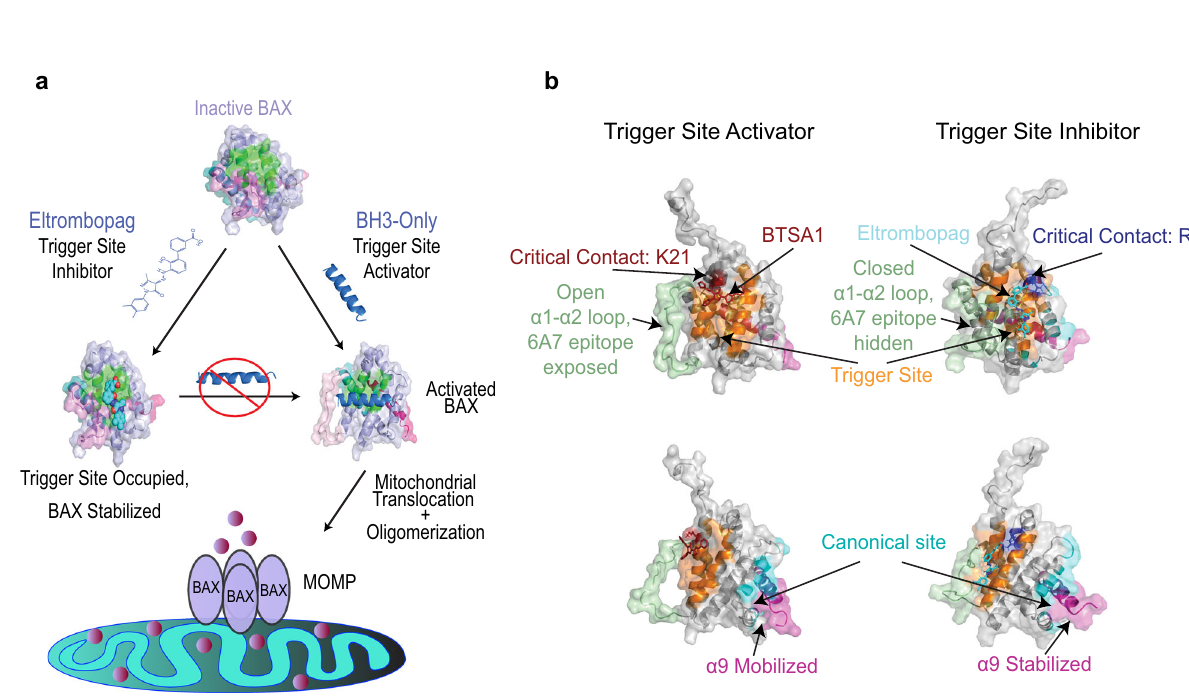
Fig. 7 Eltrombopag inhibits BAX activation by a unique twofold mechanism. a Eltrombopag ’ s binding to the BAX trigger site competes off BH3-only activator proteins of BAX and stabilizes an inactive structure of BAX resulting in inhibition of BAX activation, mitochondrial translocation, and BAX- mediated MOMP. b BAX surface representations demonstrating distinct binding modes and associated conformational effects by the BAX trigger site inhibitor, Eltrombopag, and the BAX trigger site activator,